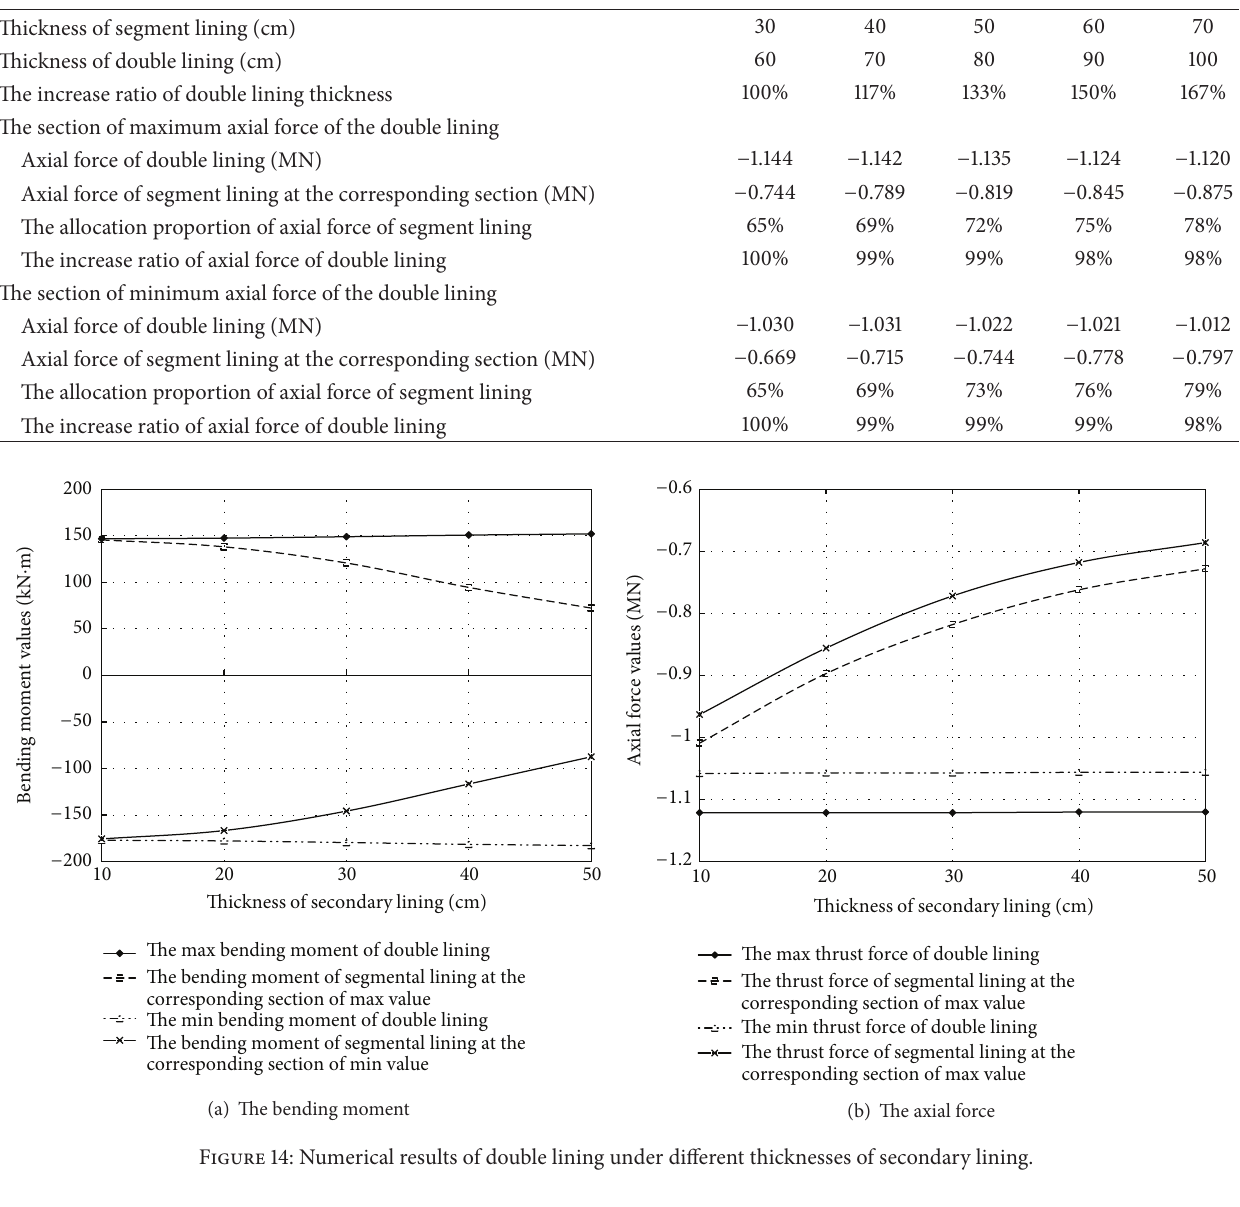
Table 7: The axial force extreme values under different thicknesses of segment lining.